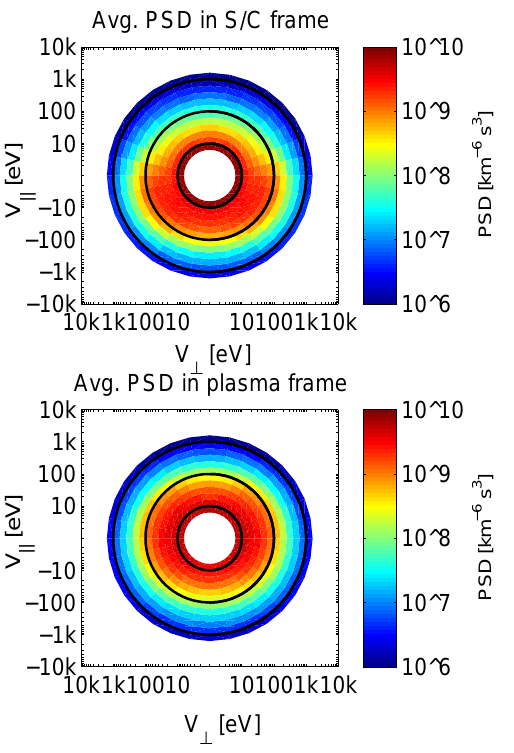
Fig. 2. Average re-binned two-dimensional cut of 3-D distributions for the entire interval. Top: original distribution in spacecraft refer- ence frame. Bottom: the same distribution after transformation to plasma rest frame. Distributions are symmetric around vertical axis (gyrotropy was assumed in the re-binning process).